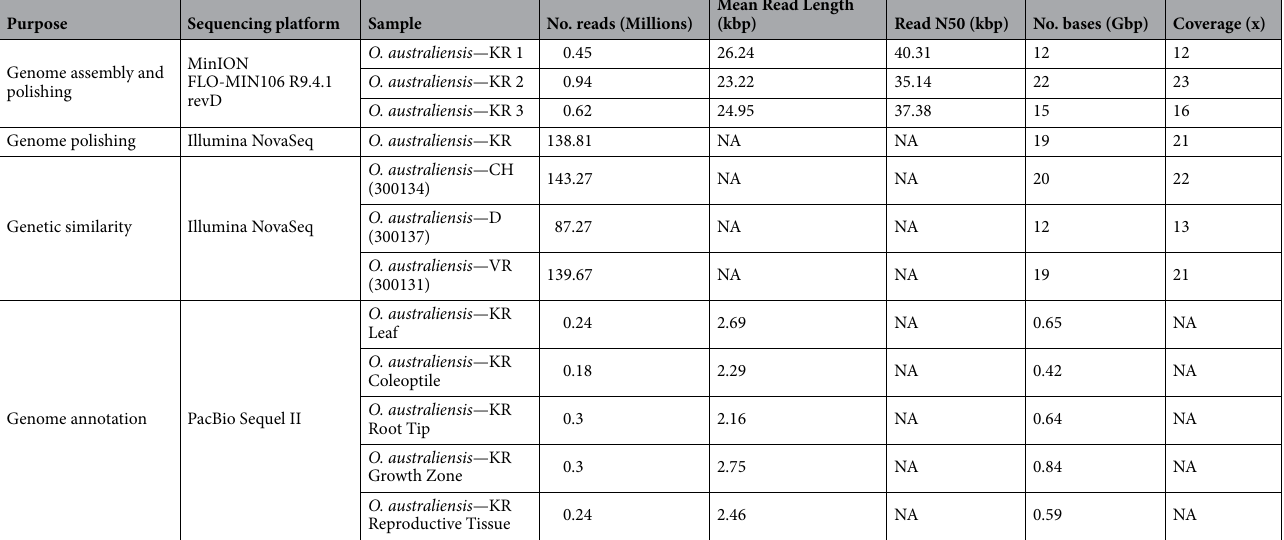
Table 1. Summary of reads used for each step of genome assembly, polishing, variant detection and annotation. See Fig. 1 for details on the accessions. KR 1, KR 2, and KR 3 are the reads obtained from a single genomic DNA preparation sequenced on three different flowcells. These reads were derived from the same O. australiensis KR plant and were used for the assembly of the reference O. australiensis KR genome. The same DNA preparation was used for the KR Illumina NovaSeq library preparation. CH, D, and VR (accession numbers appear in parentheses) refer to different accessions of O. australiensis that have been shown to vary in their tolerance to salt 20 . Reads from these accessions were used to estimate genetic similarity between the genotypes. Multiple O. australiensis KR plants were used for RNA extraction for Iso-Seq